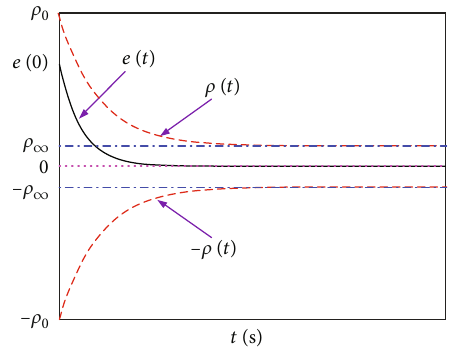
Figure 1: The prescribed performance